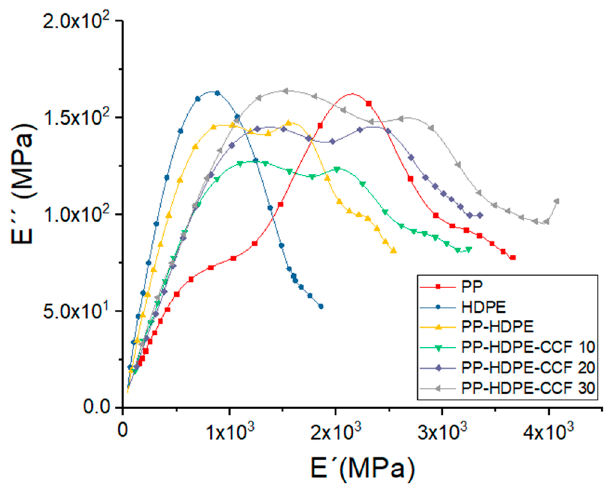
Figure 12. Cole-Cole plots of PP, HDPE, PP-HDPE blend, and their biocomposites.